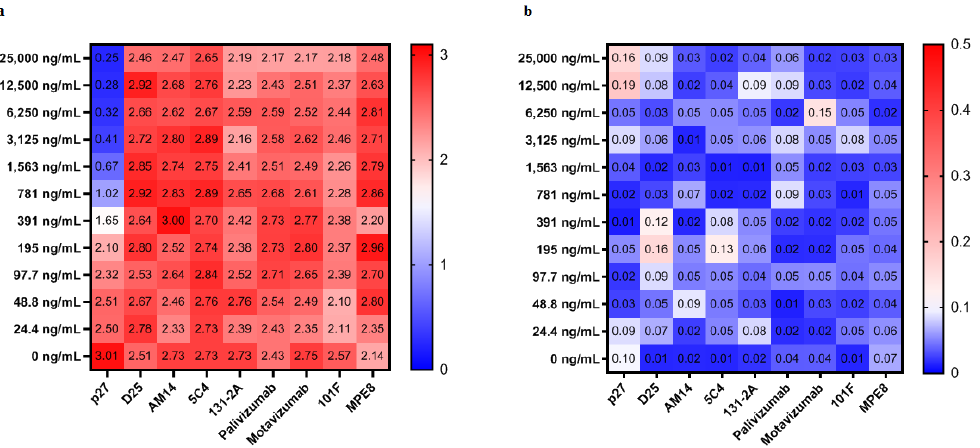
Figure 2. Sensitivity and specificity of p27 competitive antibody (P 27 CA) assay for p27 like antibody (P 27 LA) detection. ( a ) The heat map shows the average OD values of p27 like antibody (P 27 LA) from 3 independent p27 competitive antibody (P 27 CA) assays when different concentrations of p27 mAb and alternative mAbs were used in the assay. Red and blue indicate low and high concentrations of P 27 LA detected, respectively. ( b ) The heat map shows the SEs of OD values of P 27 LA from 3 independent p27 competitive antibody (P 27 CA) assays when different concentrations of p27 mAb and alternative mAbs were used in the assay. Red and blue indicate high and low of SEs calculated, respectively. The heat map was made by GraphPad Prism version 8.3.0 for Windows, GraphPad Software, La Jolla California USA.